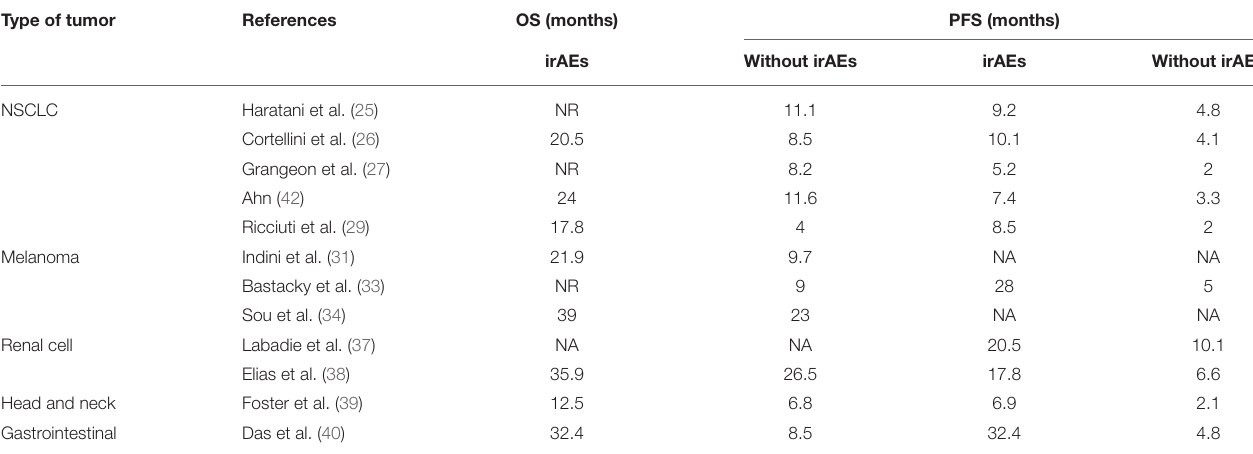
TABLE 1 | Type of tumor and OS, PFS of different studies. Type of